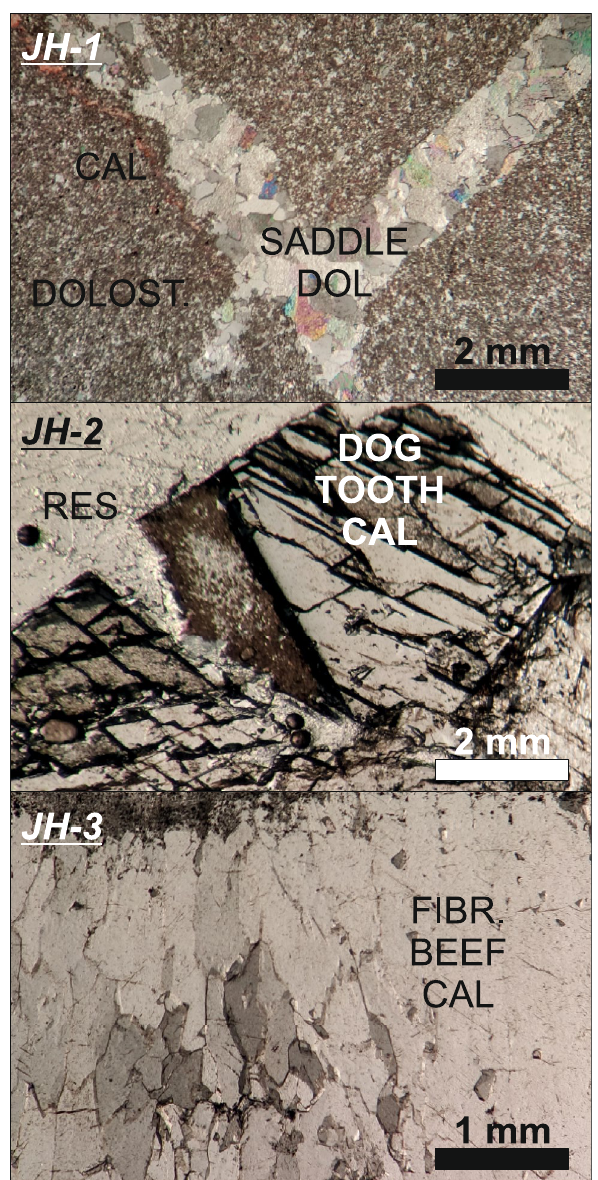
Figure 3. Transmitted (plane-polarized light) thin-section photomicrographs of samples JH-1, JH2 and JH-3. CAL calcite, DOLOST host rock dolostone, DOL dolomite, RES resin, FIBR. BEEF CAL fibrous beef